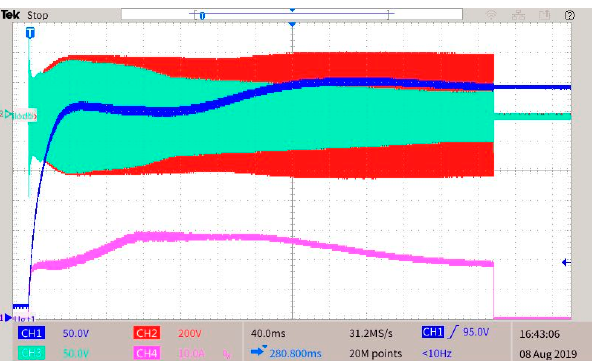
Figure 15. Pulse operation of the double-boost converter (DC-link voltage V DC and input current) and resonant converter (inverter output voltage and current of the resonant tank).